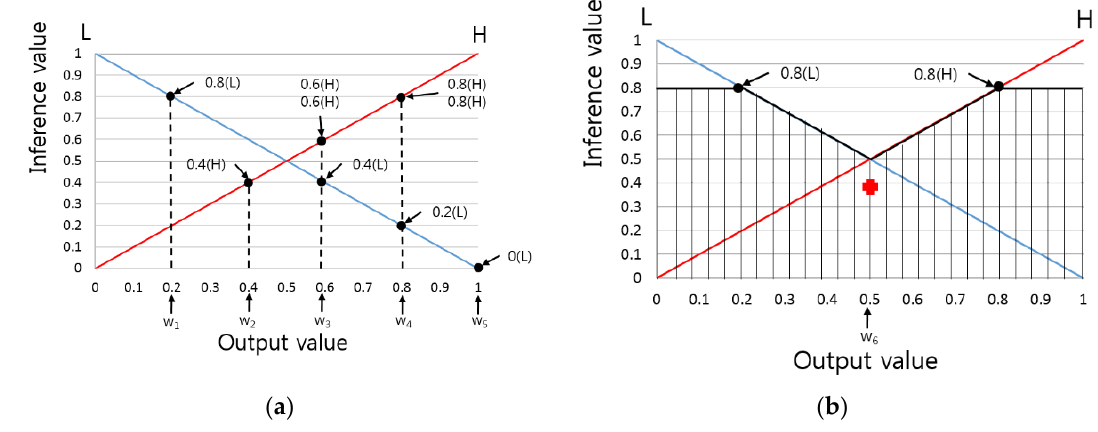
Figure 7. Examples of output values found when the IVs were used as input for various defuzzification methods: ( a ) FOM, LOM, MOM, MeOM; and ( b ) COG.